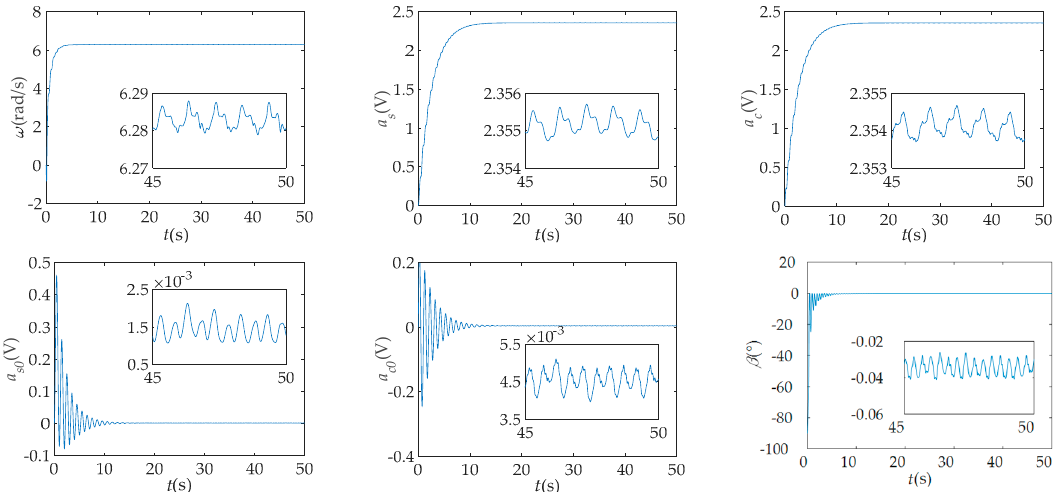
Figure 16. Estimations of angular velocity and imperfect parameters after the DWT (Group 3). Table 6. Results of calibration in